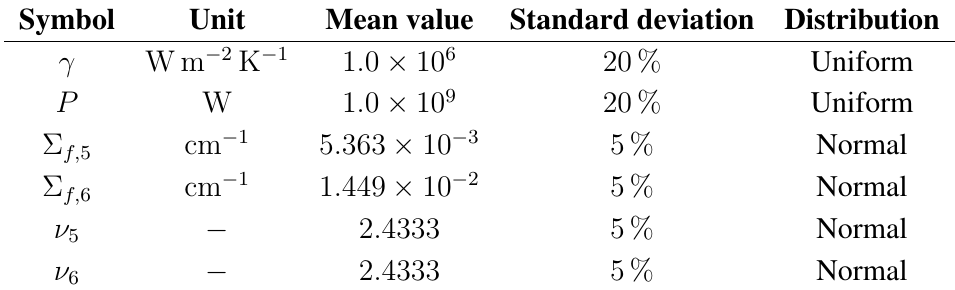
Table 2: Relevant stochastic input parameters considered in the PCE analysis and their statistical properties. The mean values correspond to the nominal